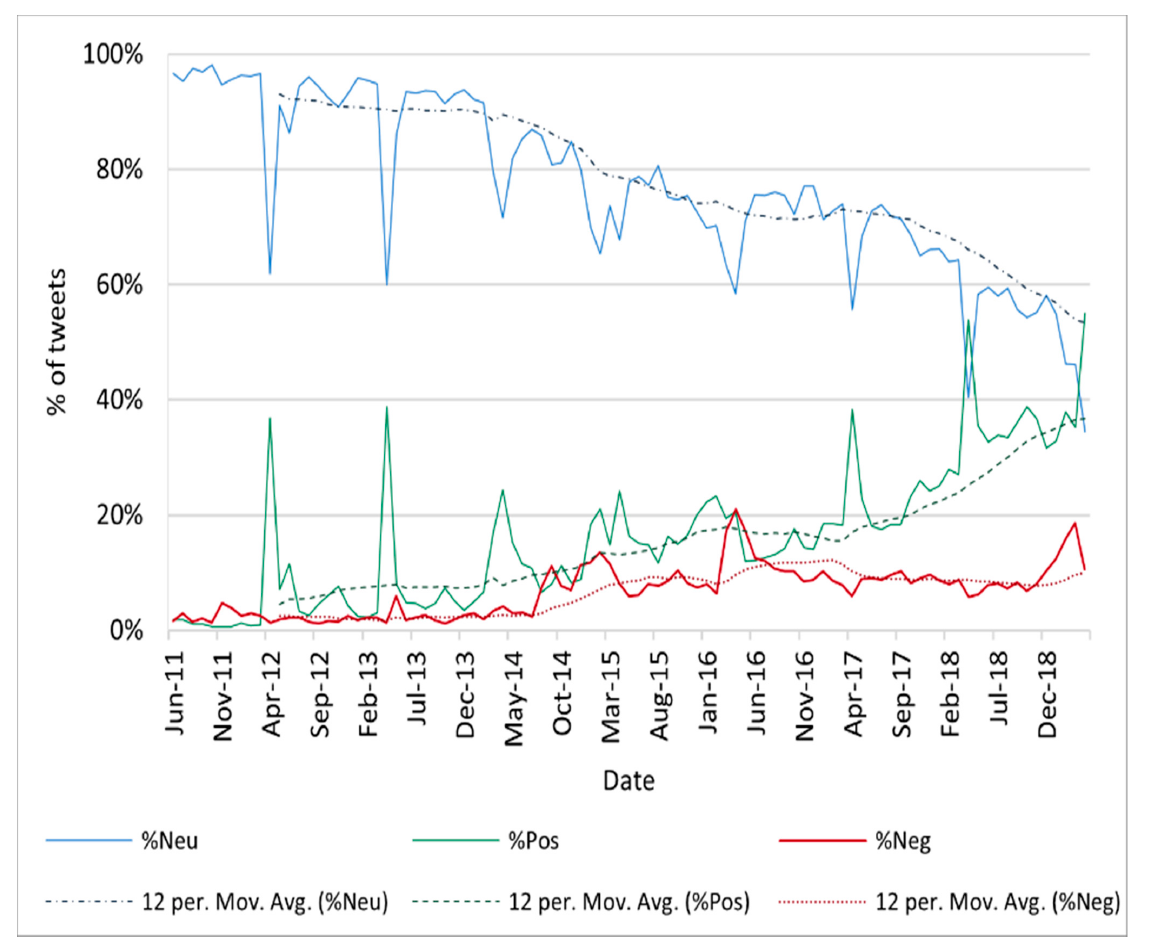
Figure 2. Relative frequency of tweets classified as neutral, positive, and negative (June 2011–April 2019).